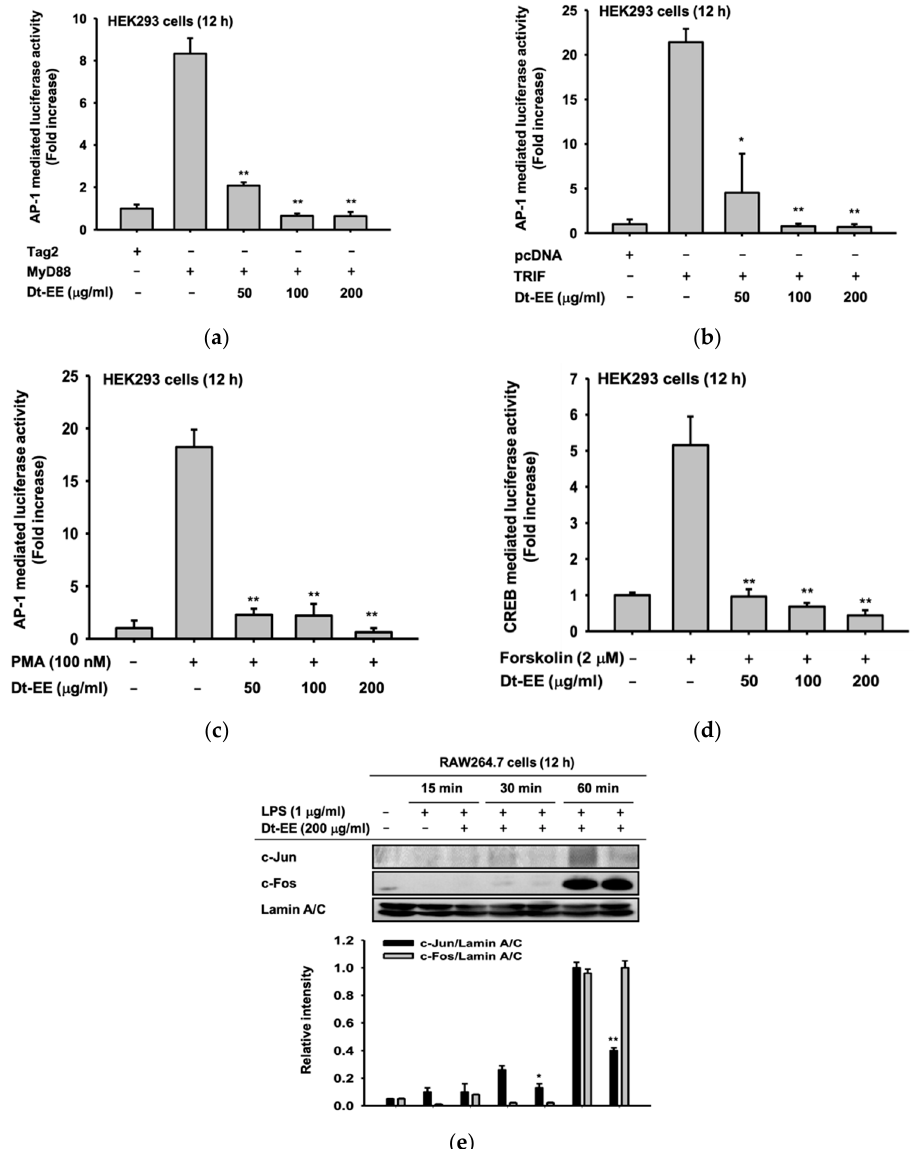
Figure 2. Effect of Dt-EE on inflammatory transcriptional activation. ( a,b ) FLAG-MyD88 or CFP-TRIF was transfected in HEK293 cells using plasmid constructs of AP-1-Luc and β -gal (as a transfection control) for 24 h, followed by treatment with Dt-EE (0–200 µg/mL) for an additional 24 h. ( c ) HEK293 cells were transfected with plasmid constructs of AP-1-Luc and β -gal (as a transfection control) for 24 h, followed by treatment with Dt-EE (0–200 µg/mL) and PMA (100 nM) for an additional 24 h. ( d ) HEK293 cells were transfected with CREB-Luc and β -gal and incubated for 24 h. Then, forskolin (2 µM) and Dt-EE (0–200 µg/mL) were administered according to the conditions shown. Luciferase activity was measured using a luminometer and normalized to that of β -gal. ( e ) The nuclear translocation levels of c-Jun and c-Fos, subunits of AP-1, and Lamin A/C were determined by western blotting of nuclear fractions from RAW264.7 cells with and without LPS (1 µg/mL) and Dt-EE (0–200 µg/mL) treatment for the indicated times. *: p < 0.05 and **: p < 0.01 compared to the induced group. Usually, IRAK1 and IRAK4 bind with MyD88, but when a cell is activated, IRAK4 activates IRAK1, and IRAK1 undergoes autophosphorylation and kinase activity and is then degraded [27]. In terms of this, the increased level of total IRAK1 by Dt-EE strongly indicates that Dt-EE can suppress kinase activity and autophosphorylation of